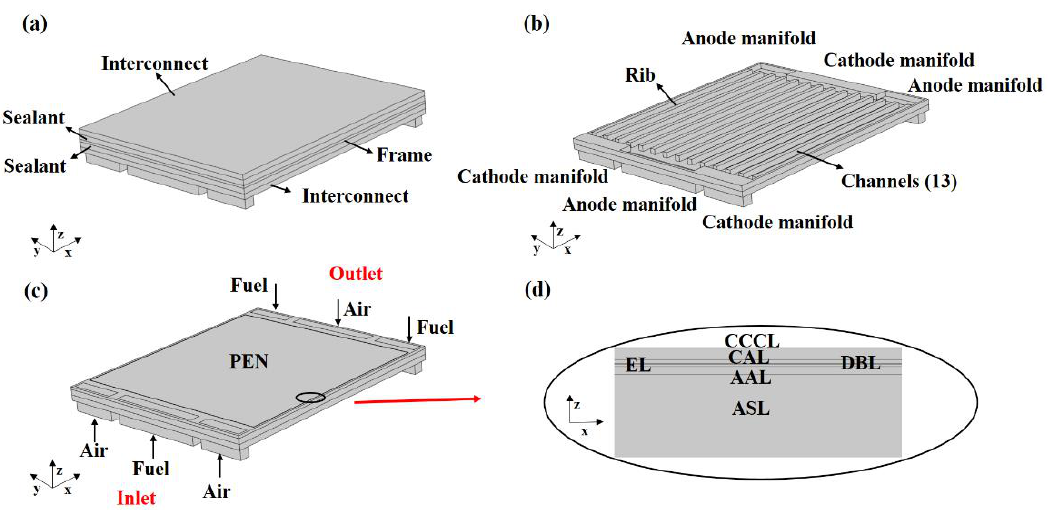
Figure 1. Geometry of anode-supported planar SOFC: ( a ) schematic of assembly system, ( b ) gas channel, ( c ) co-flow arrangement, ( d ) components of PEN.